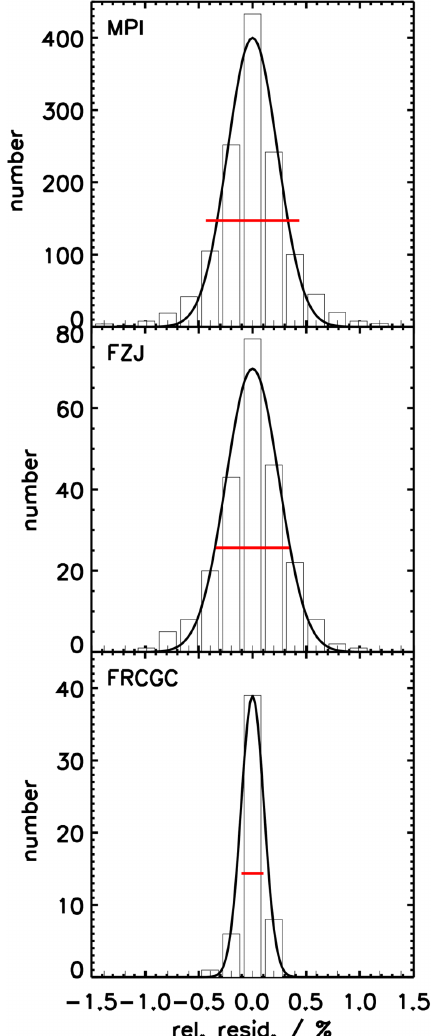
Fig. 5. Frequency distribution of the residuum of a linear fit of measurements on 22 July (1h periods when HO 2 decreased ap- proximately linearly). The frequency distribution was fitted to a normal distribution (black line). The width agrees with the mean of measurement errors (red line) within the precision of the fit for all instruments.